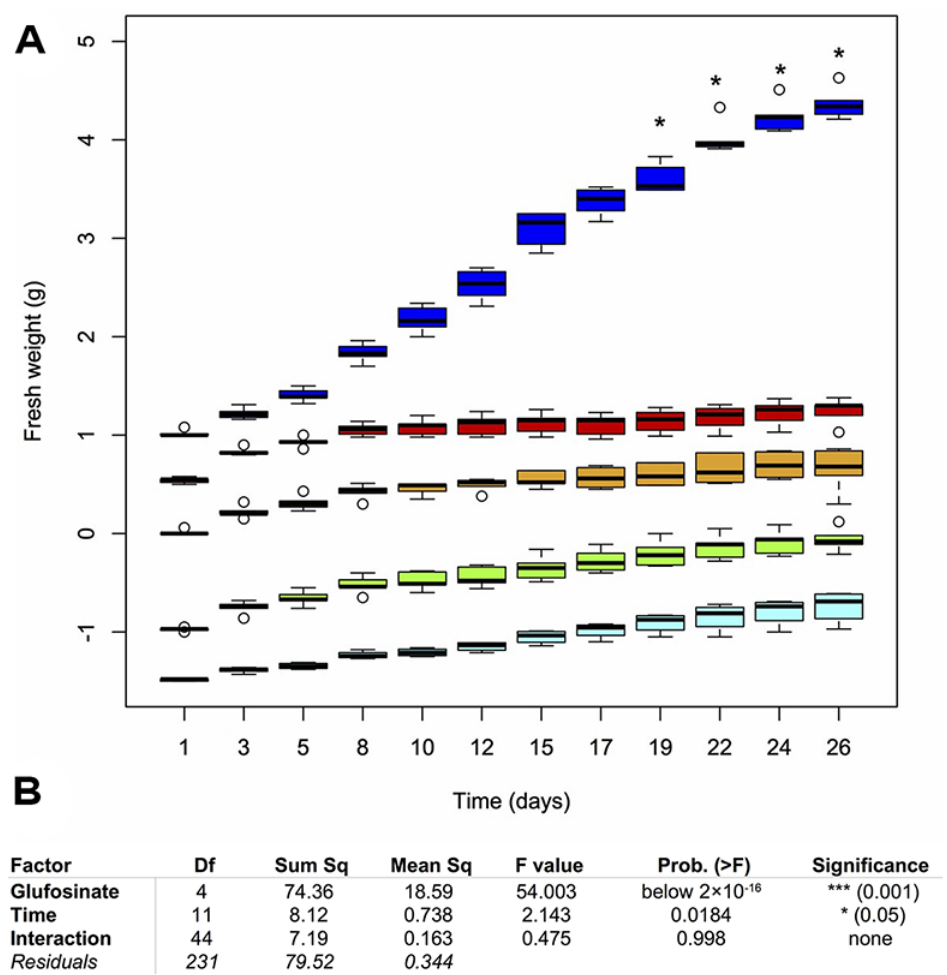
Fig. 2 Box–Wilson plots of the mass ( A ) of 1-g samples of C. annuum ‘Serrano’ calli against cultivation time in solid medium MS-B5 and in the absence (blue bars) or presence of glufosinate at 2 (red; offset 1 −0.5), 4 (orange; offset 1 −1.0), 8 (green; offset 1 −2.0), and 10 (cyan; offset 1 −2.5) mg L −1 . 1 For clarity, the plots for data in the presence of glufosinate were offset down, as indicated (* significant differences at p < 0.05 from time 0 and from glufosinate-treated cultures). The results from a two-way ANOVA are shown below ( B ) (*** significant differences at p < 0.001 apply to glufosinate factor globally). The plot ( A ) and ANOVA ( B ) were performed using R statistical software